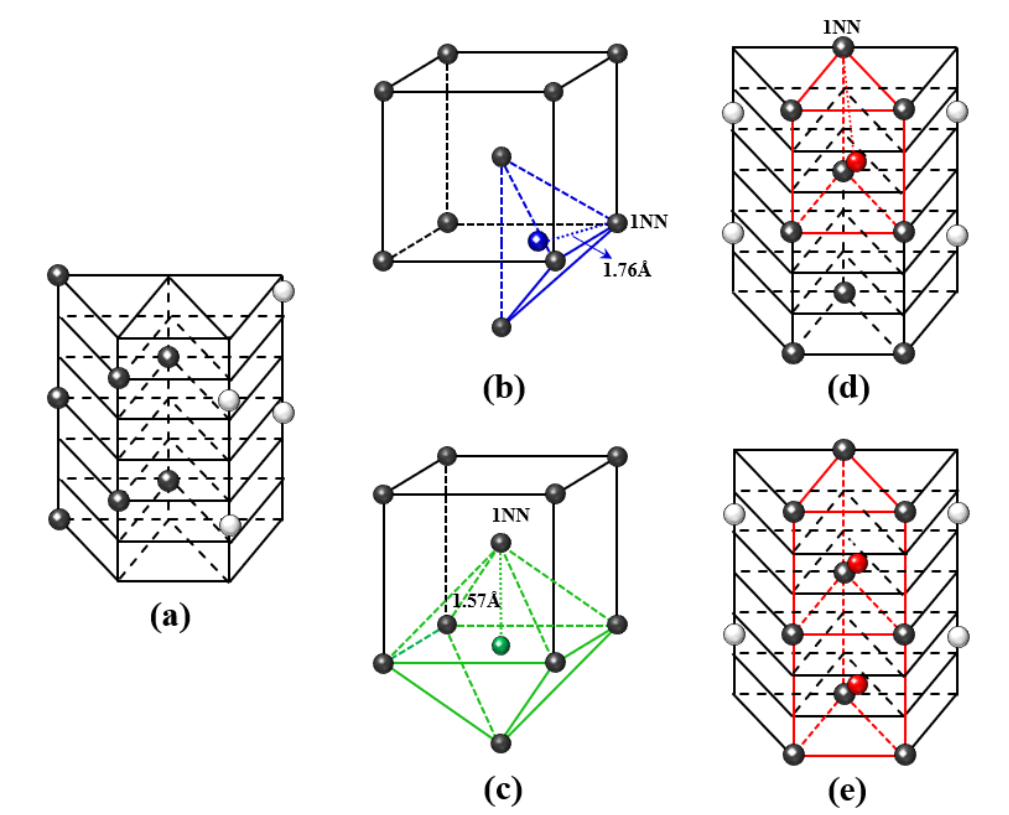
Figure 3. The atomic configuration of ( a ) easy-core dislocation, ( b ) tetrahedral interstitial site, ( c ) octahedral interstitial site and ( d , e ) reconstructed hard-core dislocation with a C–C/O–O distance of 2 b and 1 b in Mo.